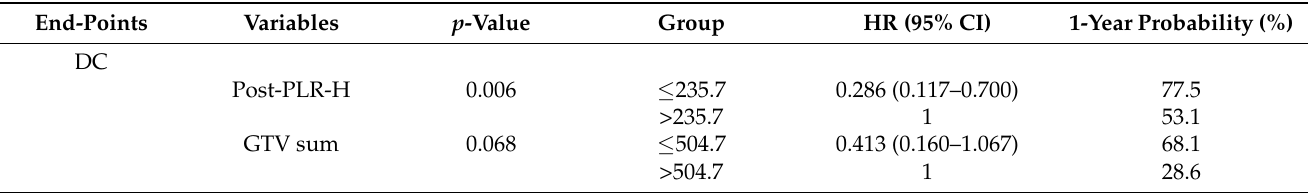
Table 5. Results of multivariate Cox proportional hazards analyses for major study end points.